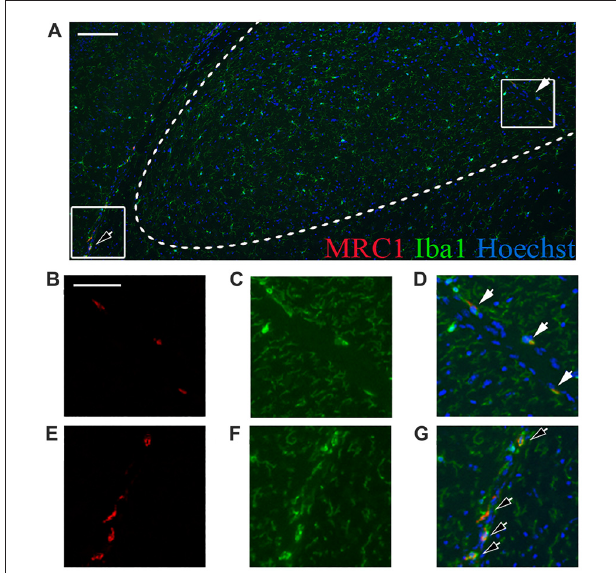
FIGURE 3 | Non-parenchymal macrophages are immunoreactive to MRC1. (A) MRC1 (red) and Iba1 (green) double-labeled cells are localized at CNS interfaces (closed and open arrows) and not in the SN parenchyma (delimited by the dashed line) in 4-month-old c-rel − / − mice. (B–D) Higher magnification of MRC1-Iba1 double-labeled perivascular macrophages (closed arrow) and Iba1-positive microglia in the SN. (E,F) Higher magnification of MRC1-Iba1 double-labeled meningeal macrophages (open arrows), and Iba1-positive microglia, outside the SN. Upper image (A) is representative of five sections from each animal ( n = 3). Abbreviations: CNS, central nervous system; SN, substantia nigra. Scale bars: in (A) = 100 µ m; in (B) = 50 µ m for (B–G) .